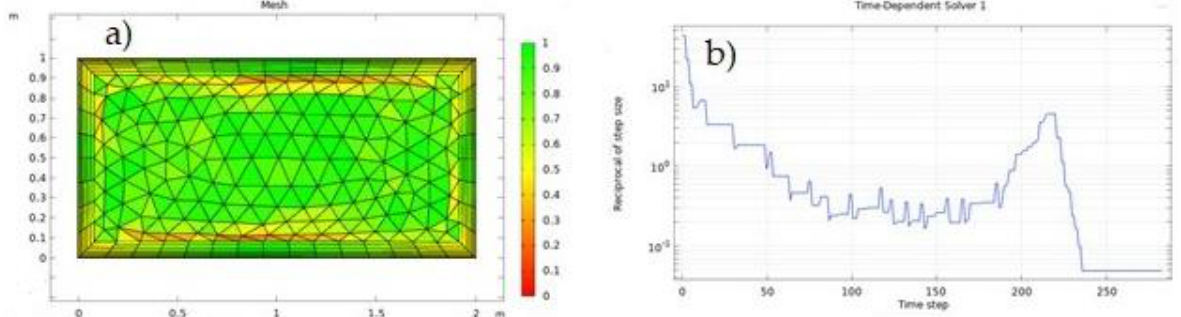
Figure 3. ( a ) Inspection of the geometry mesh in COMSOL Multiphysics and ( b ) convergence plot.